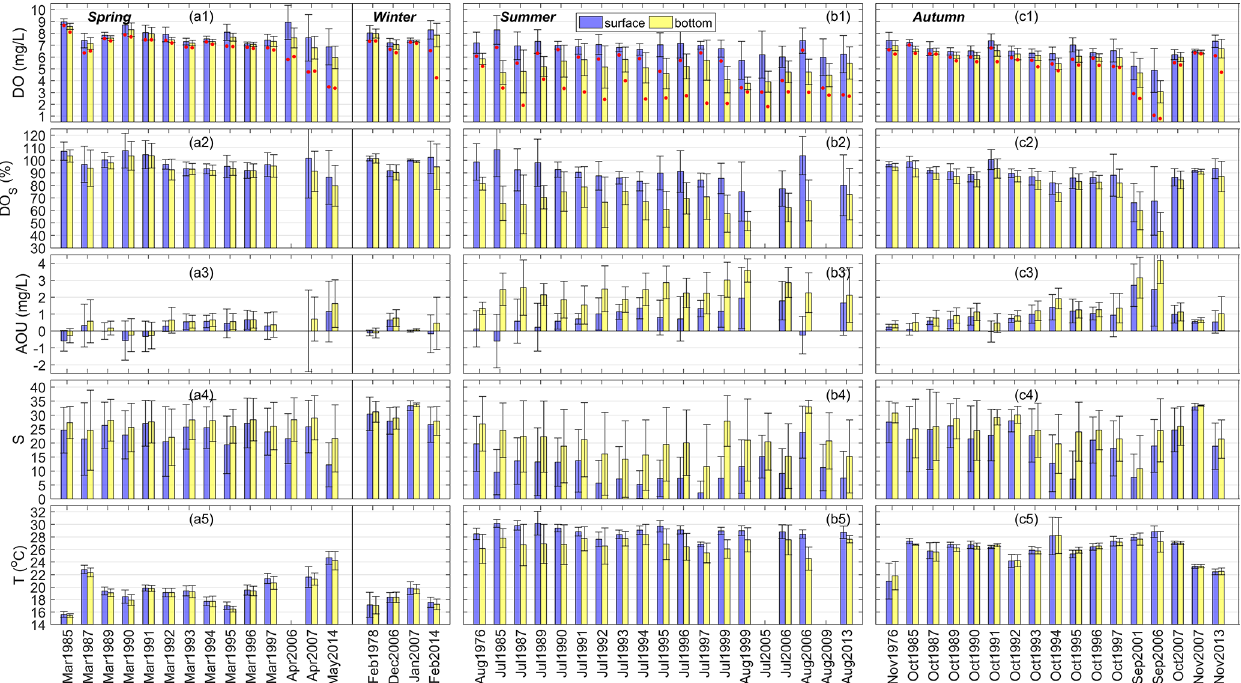
Figure 2. Spatial means and standard deviations of DO concentrations, DO saturation (DO S ), apparent oxygen utilization (AOU), salinity ( S ), and temperature ( T ) in the surface and bottom waters of the PRE in (a) spring (March–May) and winter (December–February), (b) summer (June–August), and (c) autumn (September–November) during 1976–2014. Note that the red dots in the first row of the figure represent the lowest DO values measured in each time